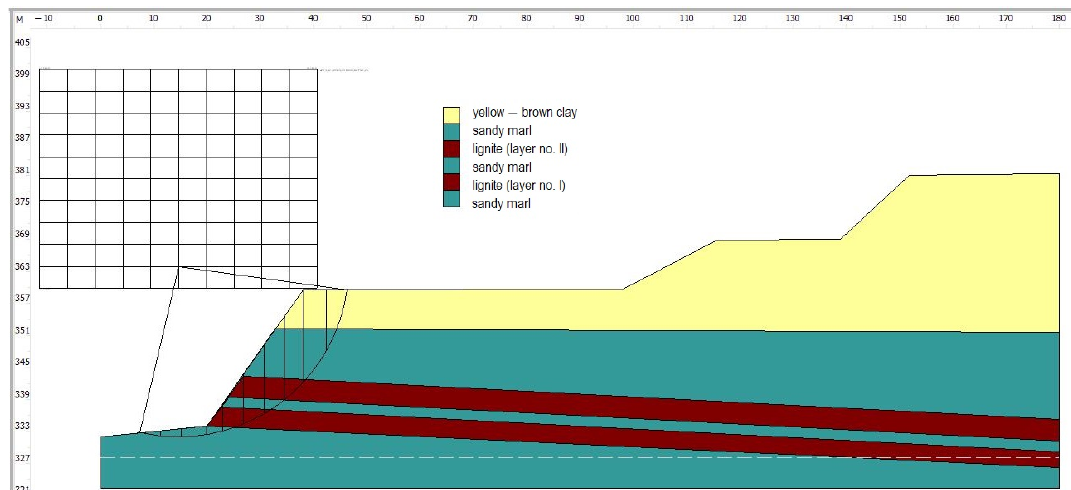
Figure 12. Section P1—Stability analysis of the lower excavation step.